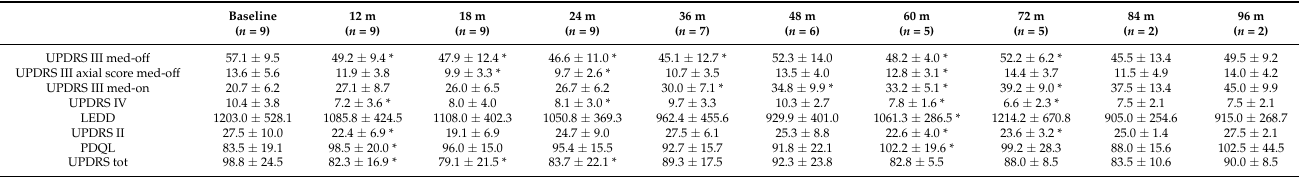
Table 2. Efficacy of stimulation in all patients, evaluated at different times after ECMS implant.